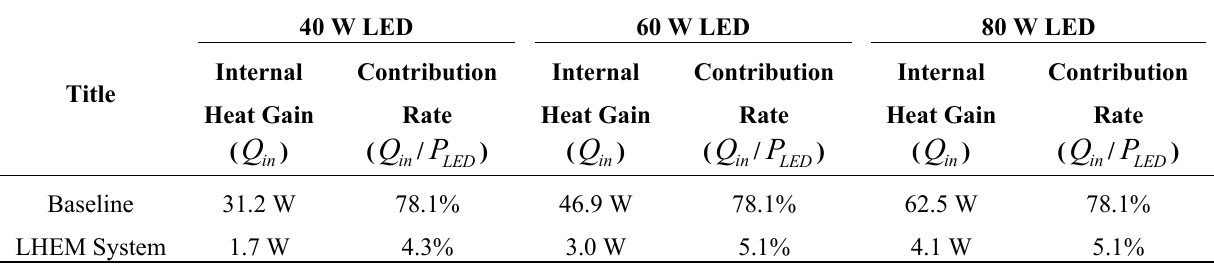
Figure 6. Output heat from the LED lighting with the LHEM system. Table 1. Internal heat gain with and without the LHEM